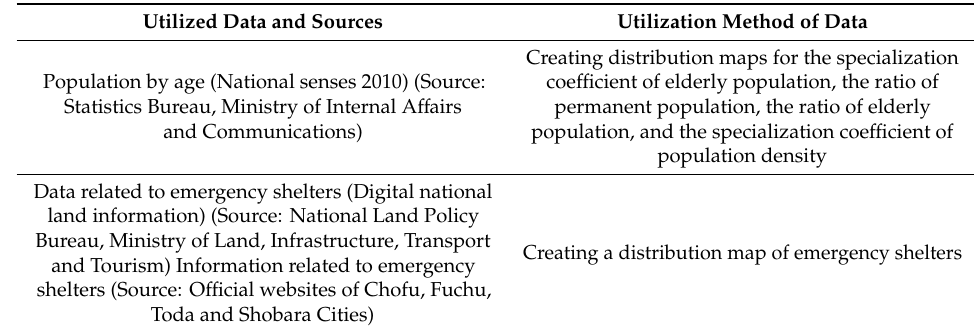
Table 3. List of utilized data.